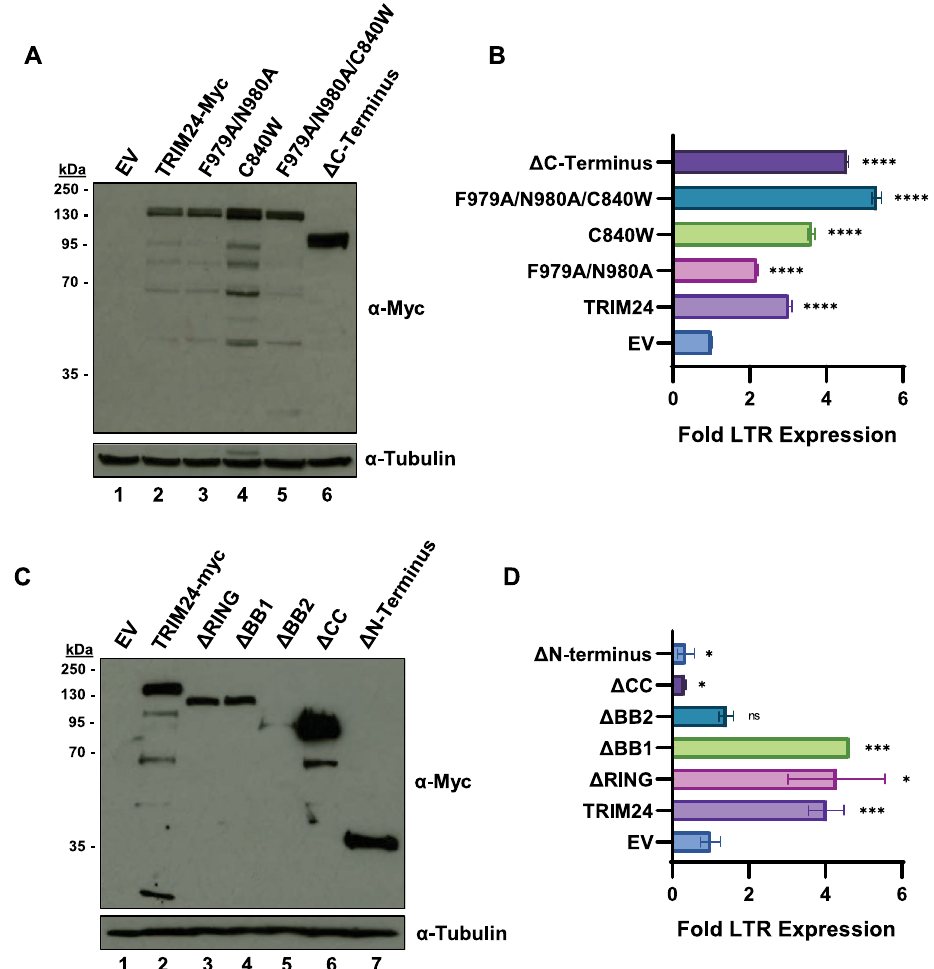
Figure 6. TRIM24 chromatin binding is dispensable for activation of HIV-1 transcription. ( A , C ) Two days post-transfection of HEK293T cells with the indicated construct, whole cell lysates were collected and immunoblotted using antibodies against Myc (top) or tubulin (bottom). ( B , D ) HEK293T cells were co-transfected with LTR-Luciferase reporter construct and the indicated TRIM24 WT or mutant expression vector. Two days post-transfection, LTR expression was analyzed by luciferase assay. Results are the average of three determinations with standard deviation indicated.